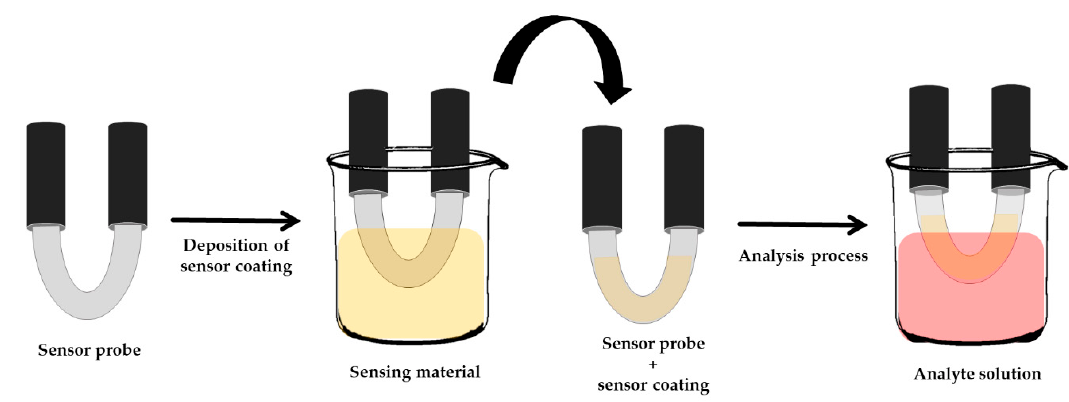
Figure 7. The development of a U-shaped probe for surface plasmon resonance [83].